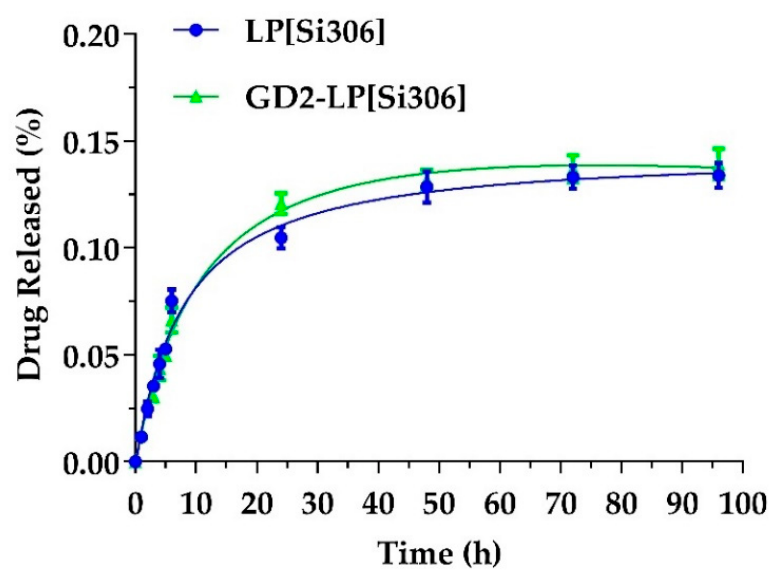
Figure 3. In vitro release of Si306-loaded untargeted (blue curve) and GD2-targeted (green curve) liposomes. The levels of cellular association of carboxyfluorescein-labeled LP[Si306] and GD2- LP[Si306] were evaluated by FCM on four human NB cell lines (HTLA-230, IMR-32, SK- S-AS and SH-SY5Y), expressing different levels of GD2, and on human healthy GD2- negative fibroblasts (Fibro 2–93), used as control. After 1 h of incubation at 4 ◦ C, the cellular association of GD2-LP[Si306] was significantly higher compared to the untargeted formulation (Figure 4).